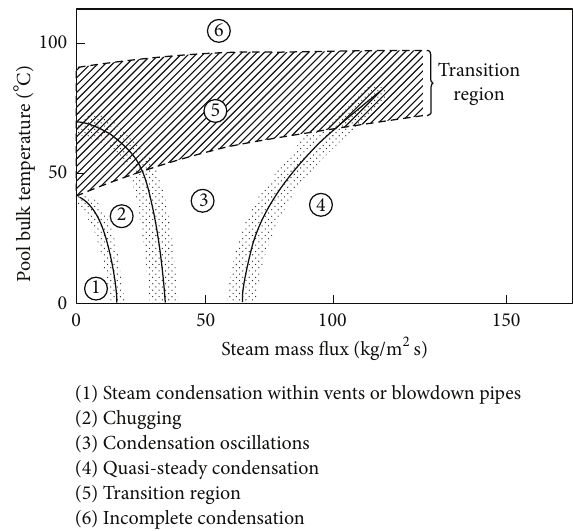
Figure 1: Typical configurations of thermal stratification in a tank (a) stratified layer and (b) thermocline layer. Note: 𝑇 ℎ : temperature of hot liquid; 𝑇 𝑐 : temperature of cold liquid.